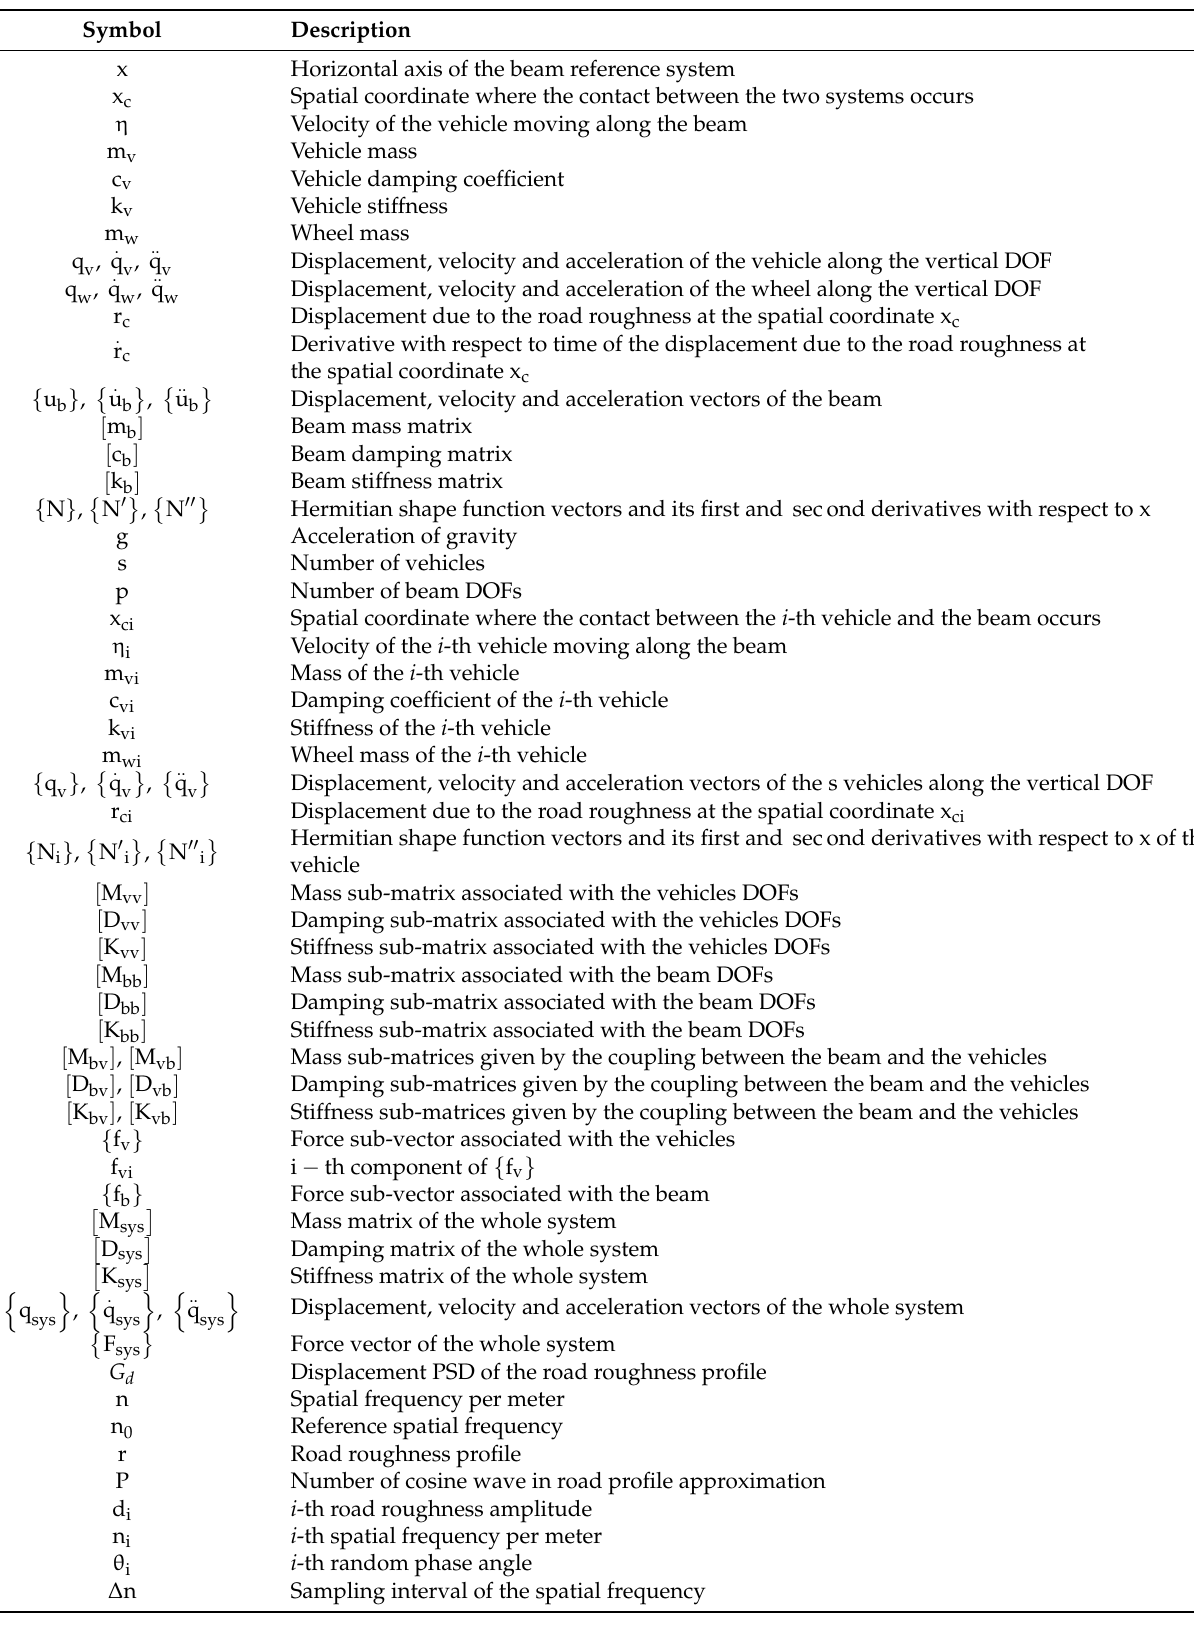
Table A1. List of